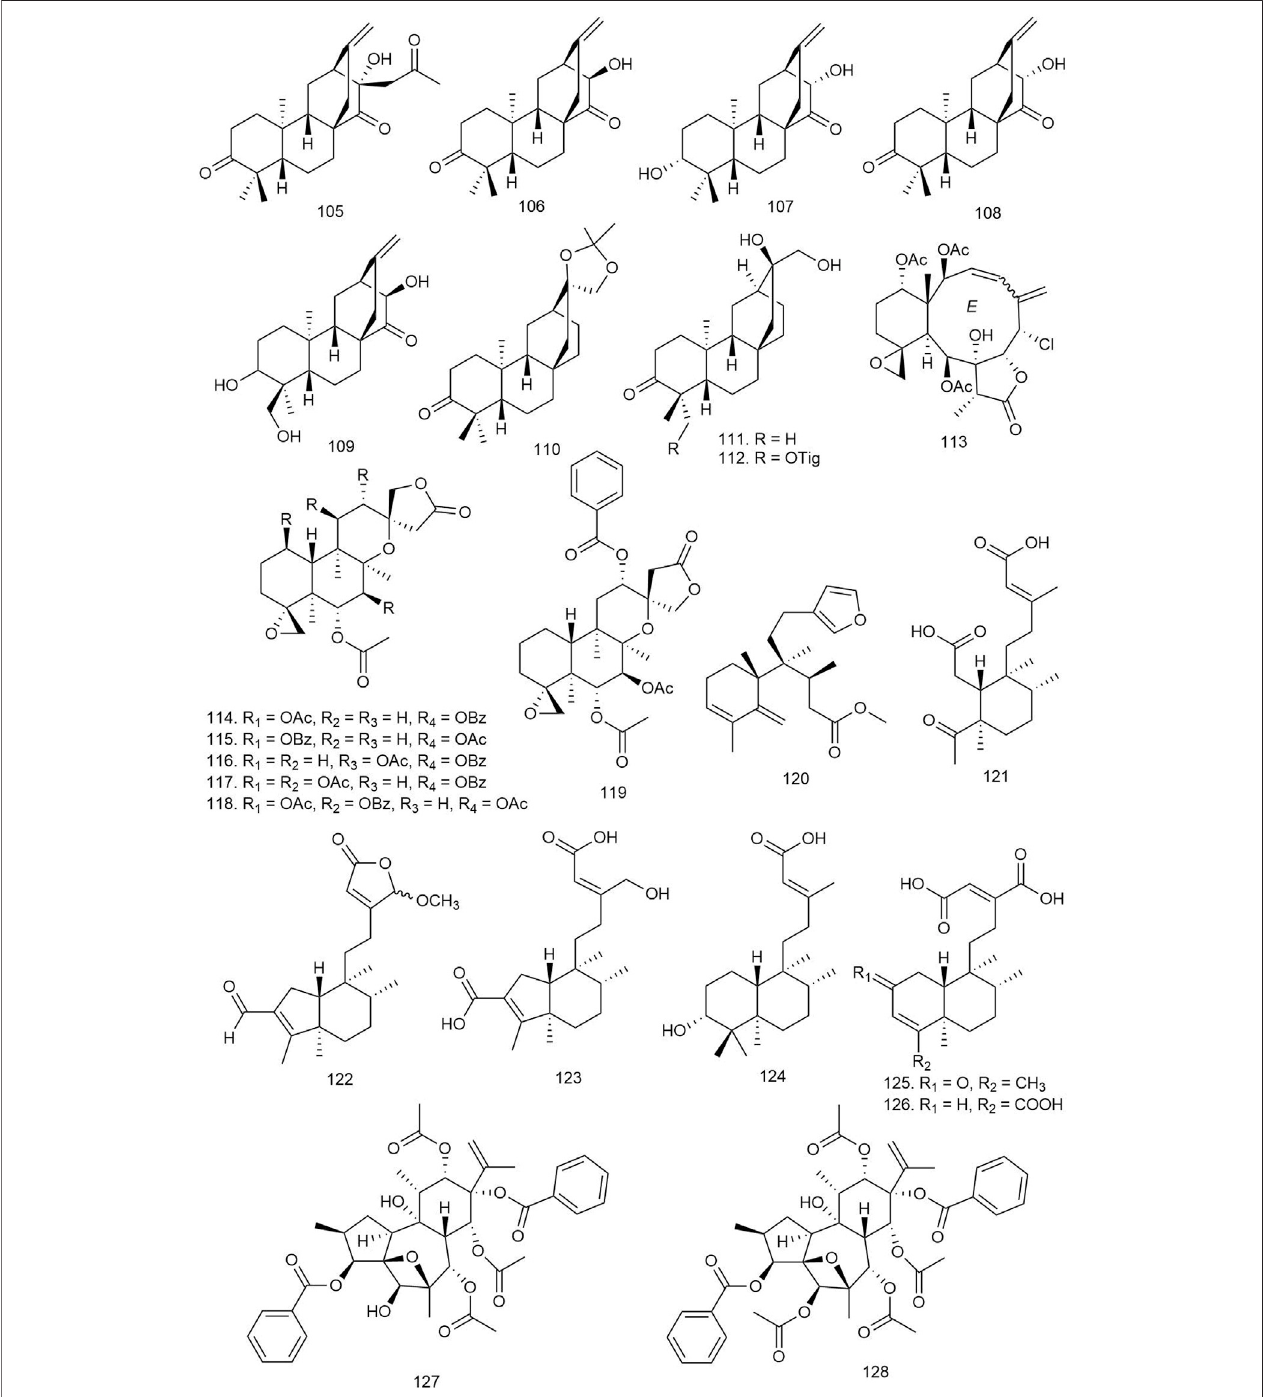
FIGURE 7 | Structures of atisane, biarane, and clerodane diterpenoids with signi fi cant antiviral activity.